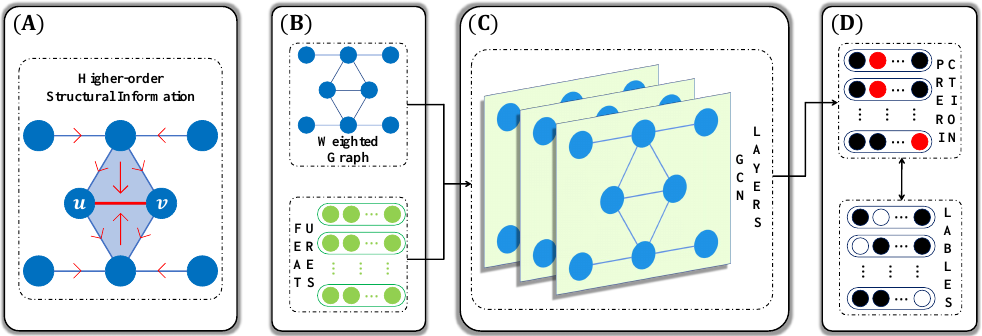
Figure 2. Overview of the HS-GCN process. Subfigure ( A ): high-order structural information is collected through high-order similarity method; Subfigures ( B – D ): graph convolution operations are performed on the weighted